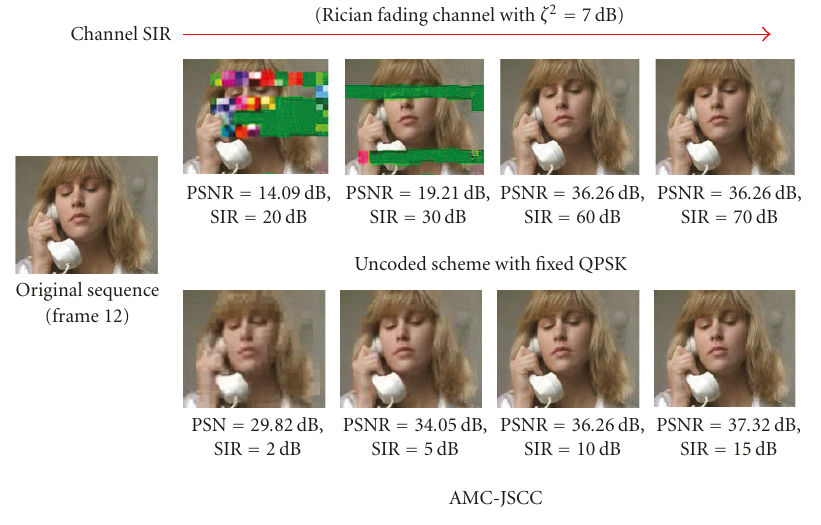
Figure 13: The 12th frame of Susie subsequence ( N = 12) with overall rate held constant at r S = 128 Ksps for an AMC-JSCC system employing RCPC codes and adaptive nonuniform 8-PSK modulation over Rician fading channel with ζ 2 = 7